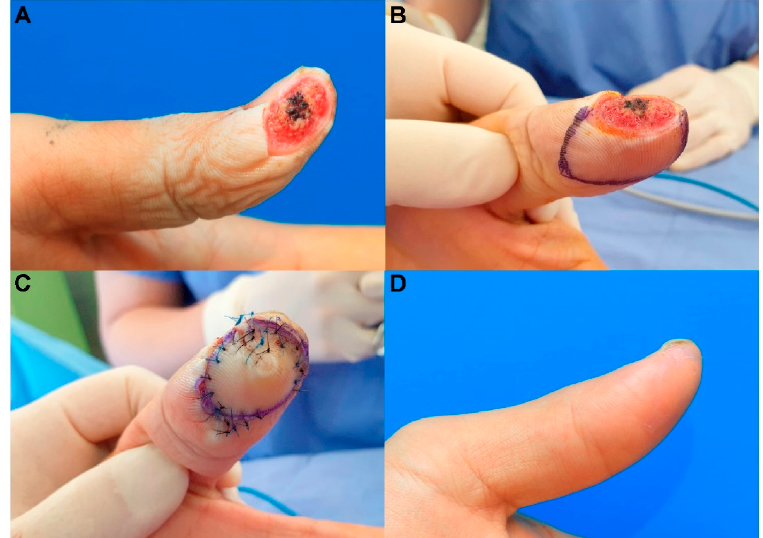
Figure 5. Clinical photographs of a 30-year-old man who sustained a left thumb fingertip injury while using a kitchen knife. ( A ) A tiny volar pulp defect of the left thumb fingertip (1.2 cm × 2.0 cm). ( B ) Design of a modified mini-keystone flap (m-KF) (1.5 cm × 3.0 cm). ( C ) Successful coverage of the defect with the modified m-KF. ( D ) Postoperative photographs obtained at the 5-month follow-up.